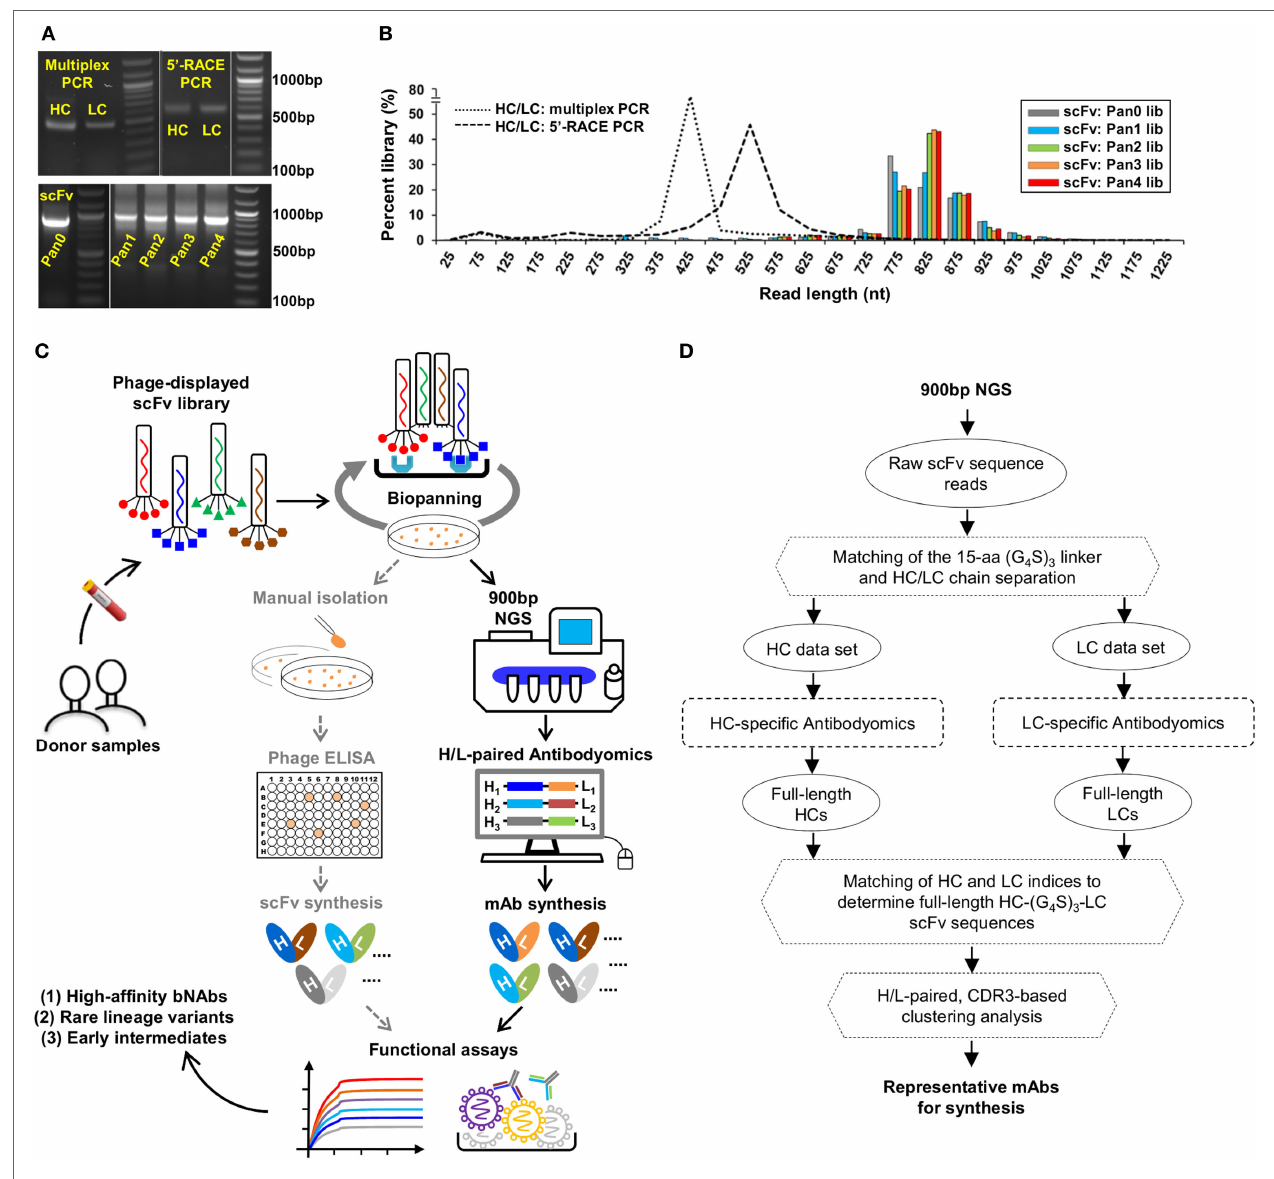
FigUre 2 | Digital panning, a quantitative method for identification of functional antibodies. (a) Gel electrophoresis of three donor-17 antibody libraries generated from multiplex PCR using gene-specific primers, 5 ′ -RACE PCR using single 3 ′ -reverse primers, and H/L-overlapping PCR using gene-specific primers. For the purpose of formatting, the DNA gel has been rearranged with splicing (labeled with white lines). (B) Read length distributions of three donor-17 antibody libraries obtained from Personal Genome Machine (PGM) sequencing. Five single-chain variable fragment (scFv) libraries are plotted as histograms and color-coded according to their antigen panning steps: gray (Pan0), cyan (Pan1), green (Pan2), orange (Pan3), and red (Pan4). The two mixed HC/LC libraries generated from multiplex PCR and 5 ′ -RACE PCR are shown as black dotted and dashed lines, respectively. (c) Schematic view of the digital panning method with the route of conventional panning included for comparison. Briefly, a scFv library is first constructed from donor peripheral blood mononuclear cells (PBMCs) and displayed on the phage surface for biopanning against an optimized antigen. The pre- and post-panning scFv libraries are sequenced on PGM to achieve 900 bp read length, with the sequenced full-length scFv libraries processed and analyzed by an H/L-paired antibodyomics pipeline. Representative scFv clones are selected for mAb synthesis and functional characterization. In HIV-1 bNAb studies, digital panning may identify high-affinity bNAb-like scFvs, rare bNAb lineage variants, and early intermediates. (D) Schematic view of an H/L-paired antibodyomics